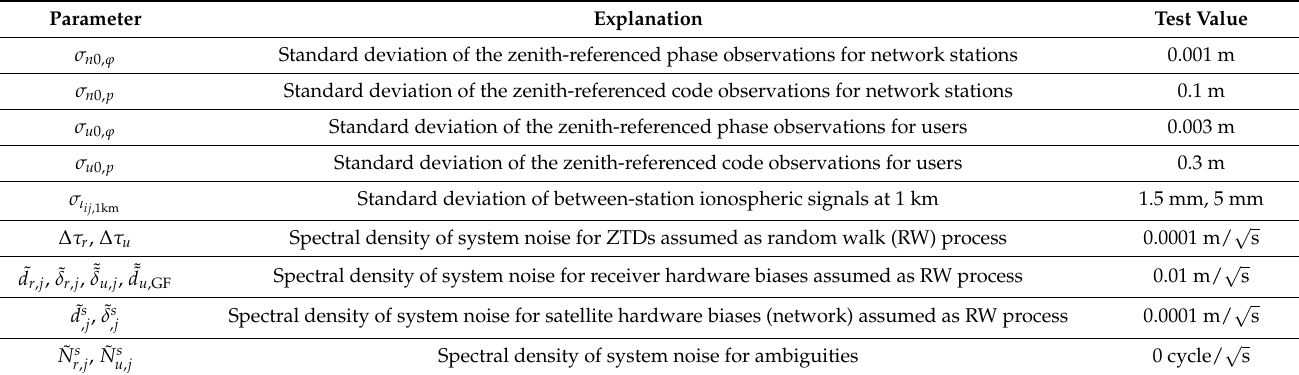
Table 4. Test values for parameters used for continuity and accuracy purposes.